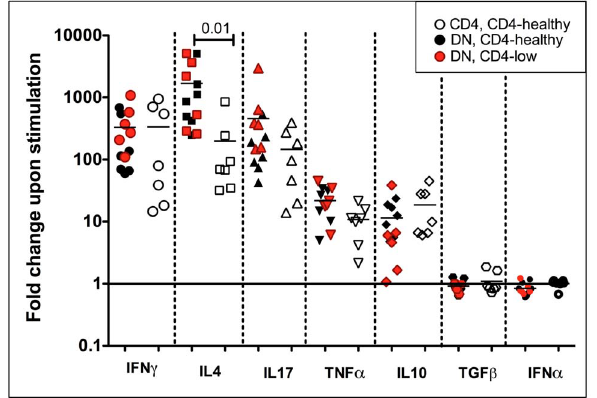
Figure 6. Quantitative real time PCR analysis of TCR stimulated DN and CD4 T cells from SIV infected mangabeys. Real time PCR analysis of purified DN and CD4 T cells isolated from SIV + mangabeys demonstrates upregulation of IFN c , IL4, IL17, TNF a and IL10 upon TCR- stimulation. Cytokine expression of DN T cells from SIV + CD4-healthy mangabeys (black symbols), SIV + CD4-low mangabeys (red symbols) and CD4 T cells from SIV + CD4-healthy mangabeys (open symbols) are depicted. Cytokine profiles of DN T cells are maintained irrespective of CD4 T cell loss. Log scale fold change is shown on the Y-axis with no change in mRNA expression due to stimulation indicated by a baseline (1 fold). Symbols represent IFN c (large circle), IL4 (square), IL17 (triangle), TNF a (inverted triangle), IL10 (diamond), TGF b (hexagon) and IFN a (small circle).